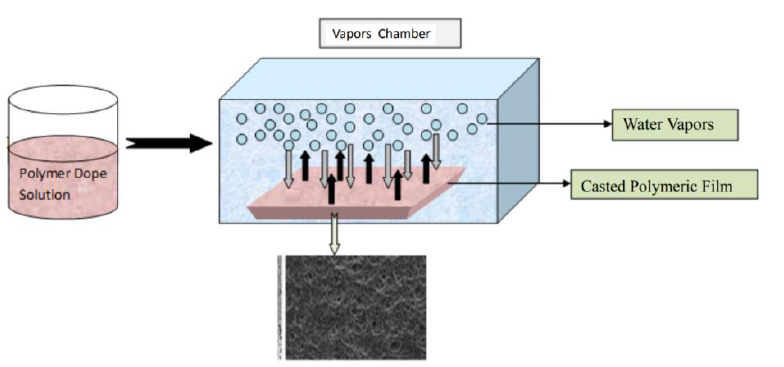
Figure 4. Vapor induced phase separation process (VIPS). Reprinted from [25], Copyright 2018 Journal of Membrane Science and Technology.